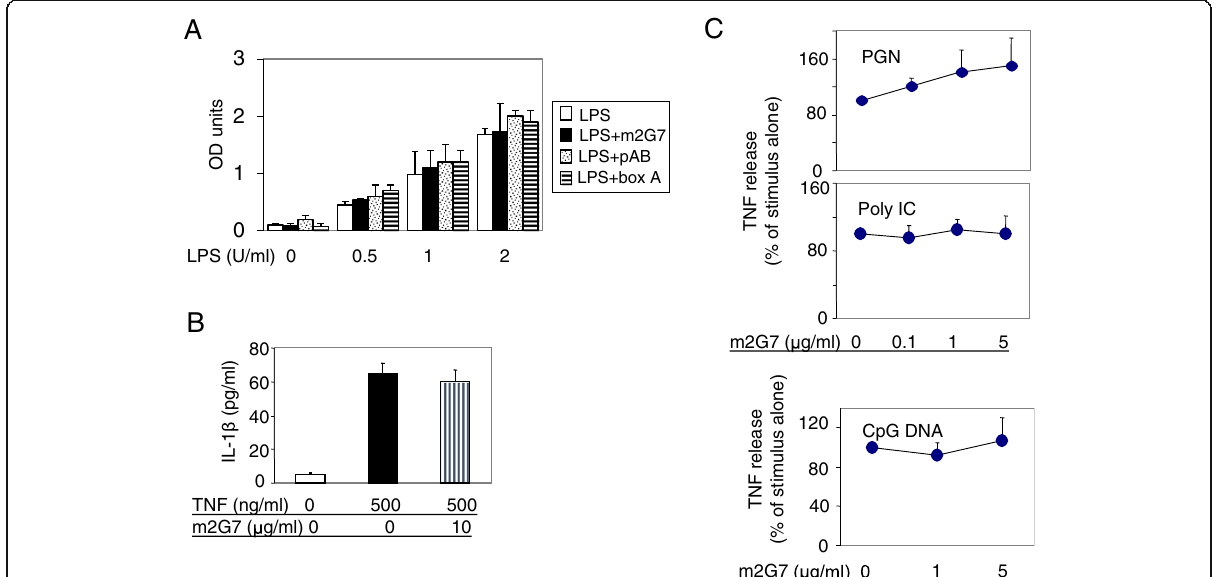
Fig. 2 Neither anti-HMGB1 antibodies nor box A suppressed LPS activity in the Limulus assay; m2G7 did not suppress pro-inflammatory cytokine release induced by TNF, peptidoglycan (PEG), Poly I: C or CpG DNA from human macrophages. a . Polyclonal anti-HMGB1 antibody (pAB, 1 µg/ml), m2G7 (1 μ g/ml) or box A (10 μ g/ml) were added to LPS (from 0 to 2U/ml) solution and incubated at 37°C for 30min and limulus assay was performed. Results are representative of 2 separate measurements each done in triplicate. b . Primary human macrophages in 96-well culture plate (5×10 4 cells/well) were stimulated with mouse TNF in the presence or absence of m2G7 for 16h. IL-1 β released was measured. N =3 experiments. c . Primary human macrophages in 96-well culture plate (5×10 4 cells/well) were stimulated with TLR 2 agonist PGN (5 μ g/ml), TLR3 agonist Poly I:C (50 μ g/ml) or TLR9 agonist CpG DNA (1 μ M) for 16h. TNF released was measured. N=3 separate